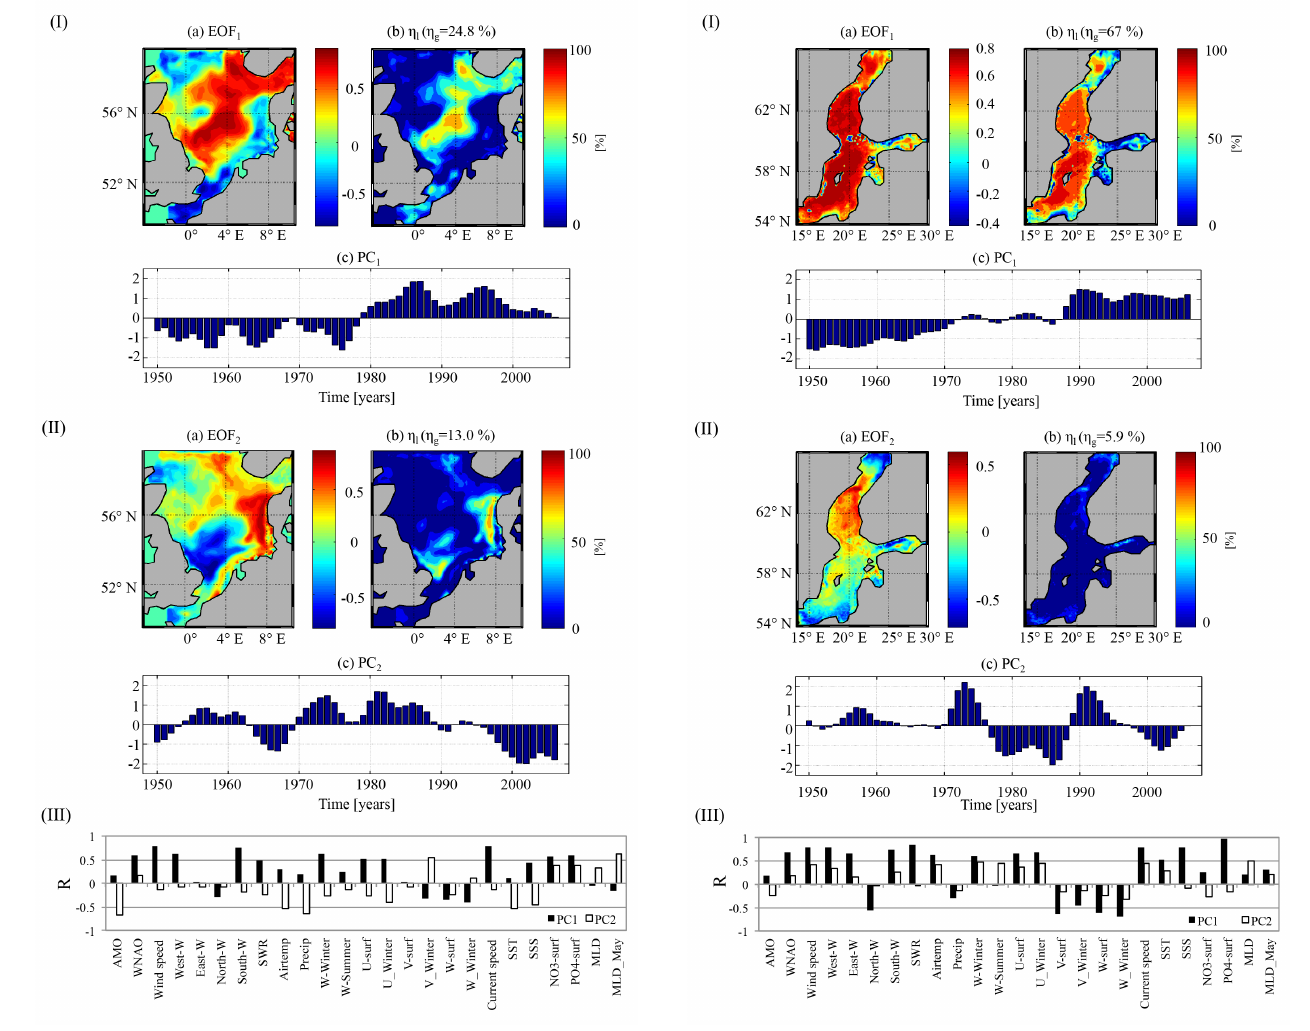
Figure 9. (I and II) (a) First and second empirical orthogonal func- tions for annual mean primary production in the North Sea (1948– 2008); (b) local explained variance for the pattern for the corre- sponding EOF; (c) principal component (time variation) of the cor- responding EOF. (III) Absolute values of the correlation coefficient between the principal components (PC1 & PC2) and an environ- mental variable stated on the x axis.